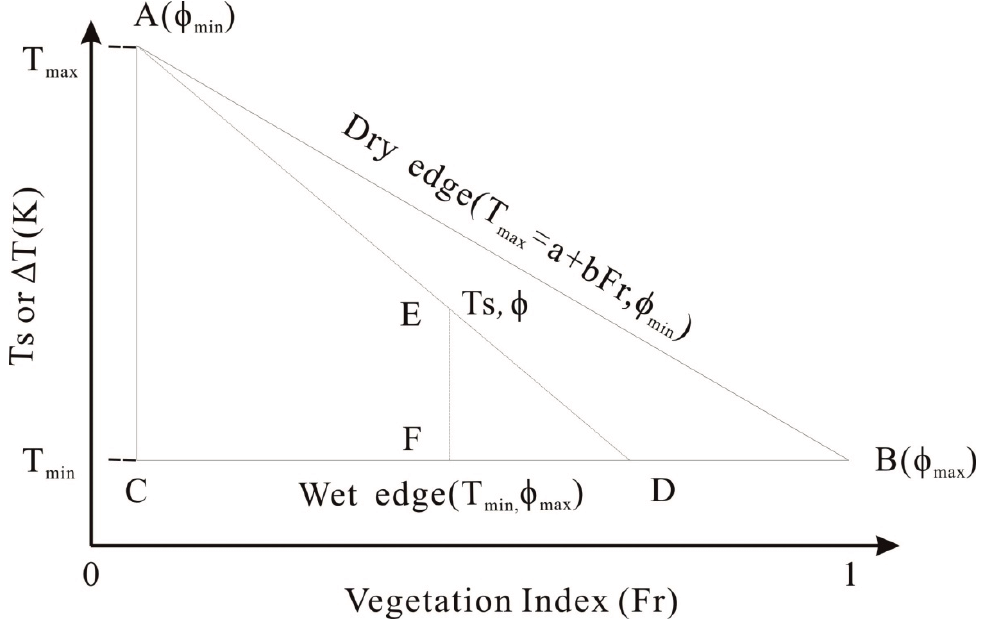
Figure 2. A theoretical diagram of the surface temperature/vegetation index